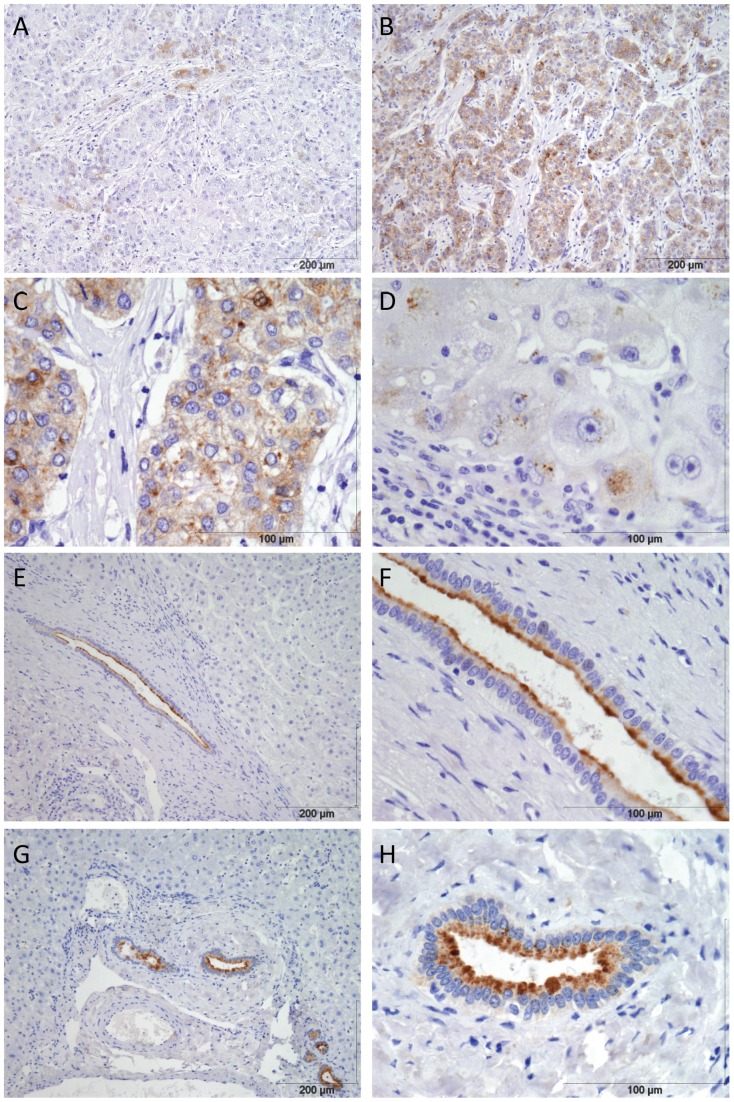
SPINK1 protein is detectable in HCC originating in different liver diseases but is only expressed in bile duct epithelium in liver cirrhosis and normal liver.Immunohistochemistry for SPINK1 A) Occasional positive tumour cells in HCC on background of HBV cirrhosis B) High frequency of SPINK1 expression in HCC on background of HCV cirrhosis at 10× magnification C) Same case as (B) at 40× magnification, showing cytoplasmic tumour cell expression D) Patchy periportal hepatocyte SPINK1 in advanced primary biliary cirrhosis 40× magnification. E) Background liver cirrhosis (HH) showing positive SPINK1 in large bile duct at10× magnification. F) Same case as (E) at 40× magnification showing SPINK1 localised to luminal surface of large bile duct. G) Normal liver showing positive SPINK1 in large bile duct at10× magnification. H) Same case as (G) at 40× magnification showing SPINK1 localised to luminal surface of large bile duct.